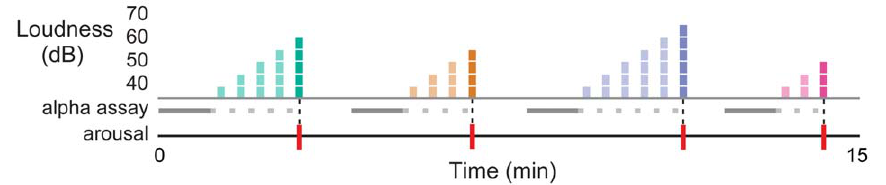
Figure 2. Sleep depth was probed with auditory stimulation. We systematically probed sleep depth with auditory stimulation during bouts of N2, N3 and REM sleep. Ten-second noises were initiated at 40 decibels (dB) and presented every thirty seconds in 5 dB increments until the EEG signal was perturbed (arousal, vertical bars on the bottom line). Each color represents a different sound type; a sample of four is shown here. The sound intensity required to disturb subjects provided an experimental measure of their immediate sleep depth. The gray windows beneath the sound level delineate periods during which alpha power was measured to predict sleep fragility.